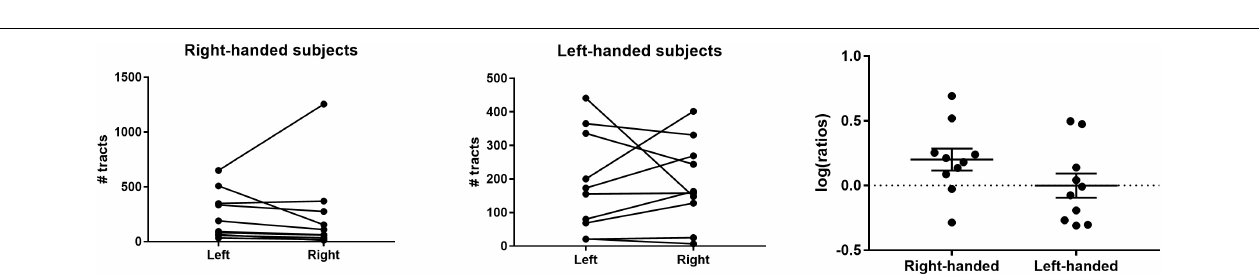
FIGURE 4 | Using single-shell “clinical grade” dMRI data to reconstruct the afferent and efferent tracts of the LHb. Axial T1 MR images with superimposed streamline density maps of LHb fiber tracts are shown for a representative subject. Single-shell/lower b -value dMRI does not reconstruct the streamlines as faithfully as the multi-shell/higher b -value data. Left hemisphere streamlines are colored in red and right hemisphere streamlines are colored in blue.